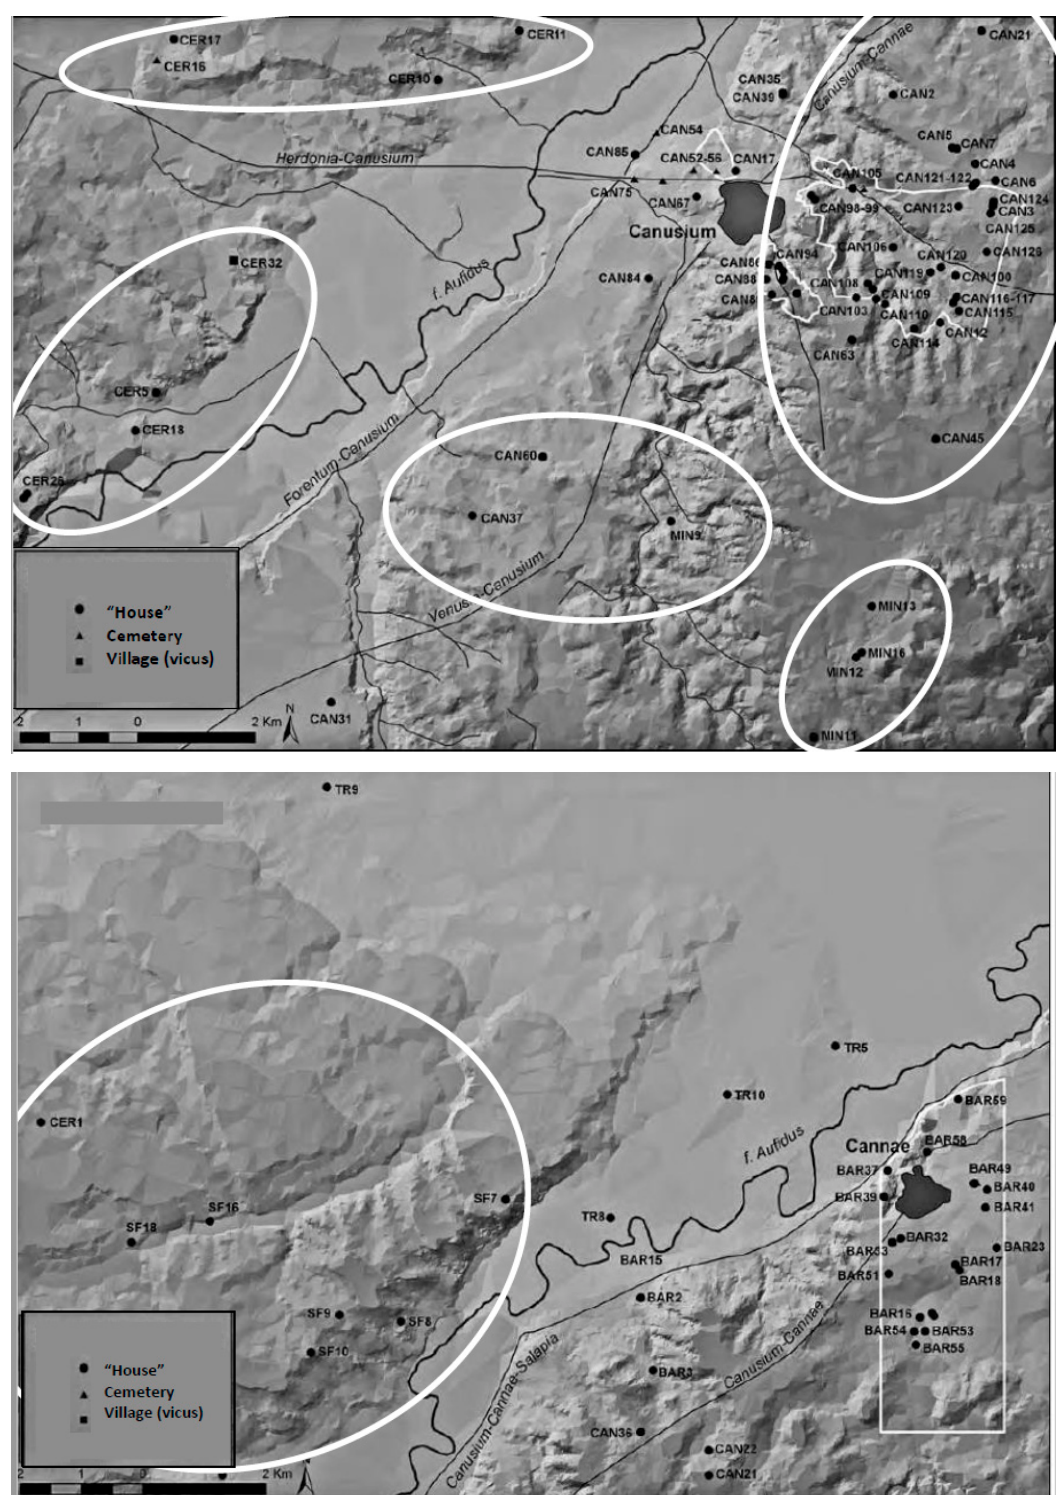
Figure 3. Sites around Canusium ( top ) and Cannae ( bottom ) identified in the Ofanto survey, late fourth-third centuries BCE; circles indicate new sites in the Tavoliere (northwest) and Murge (southeast; adapted from Goffredo 2010 with permission).